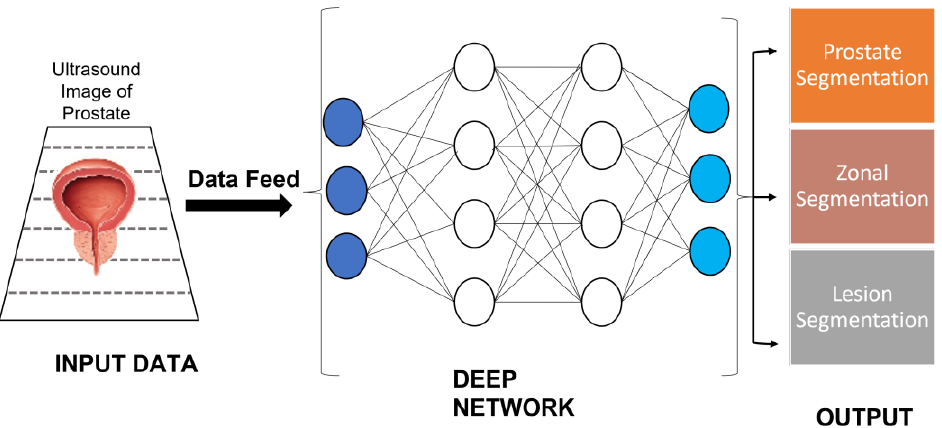
Figure 5. Application of deep neural network to classify segmentation in prostate cancer using TRUS image. Herein, input data: data collected from the medical examination of patients and healthy individuals. Data feed: sending structured and processed data to the machine learning model. Deep network: the architecture of machine learning model. Output: prediction for a different types of prostate cancer segmentation.